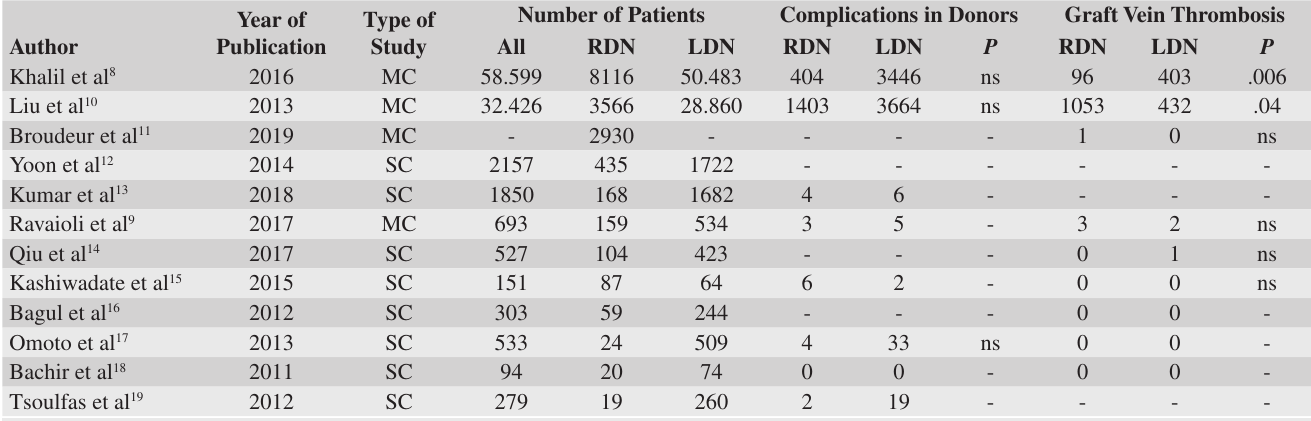
Table 3. Publications in the Period of 2009-2019 Agreeing with the Safety of the Right Donor Nephrectomy